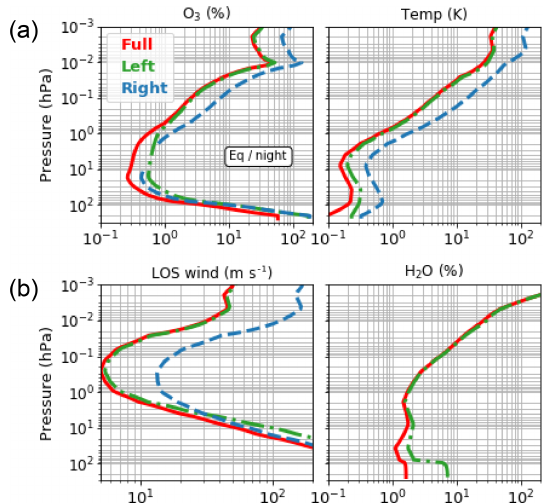
Figure 8. Single-scan retrieval precision (1 σ ) for O 3 and tem- perature (a) , and line-of-sight wind and H 2 O (b) . Errors are cal- culated for a full band retrieval (red lines), the left half IF band (10.075–14.075GHz, blue lines) and the right half IF band (14.075– 18.075GHz, green lines). Results are shown for equatorial night- time